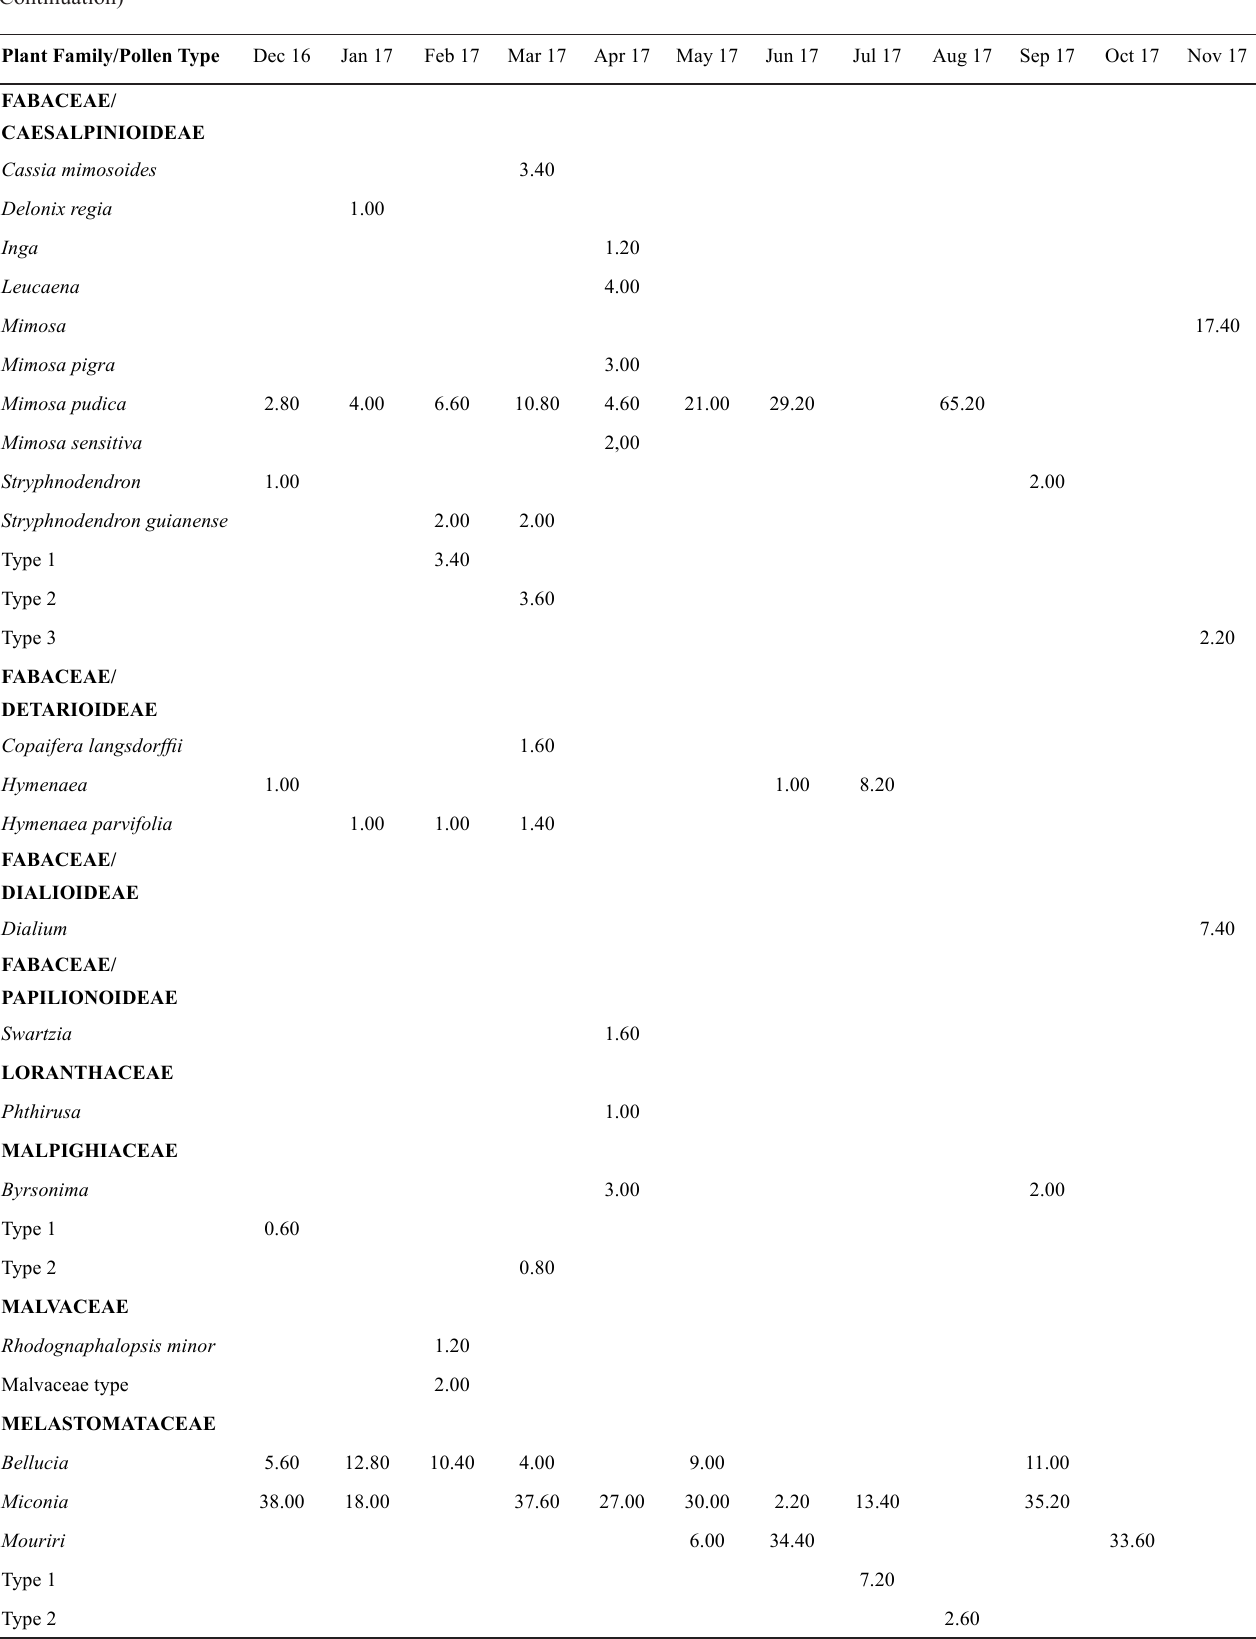
Table 1 . Frequency of pollen types found in honey samples of Melipona seminigra pernigra (Apidae: Meliponini) collected from December 2016 (Dec 16) to November 2017 (Nov 17) in the community of Suruacá, Tapajós-Arapiuns Extractive Reserve, Santarém (PA), Brazil.